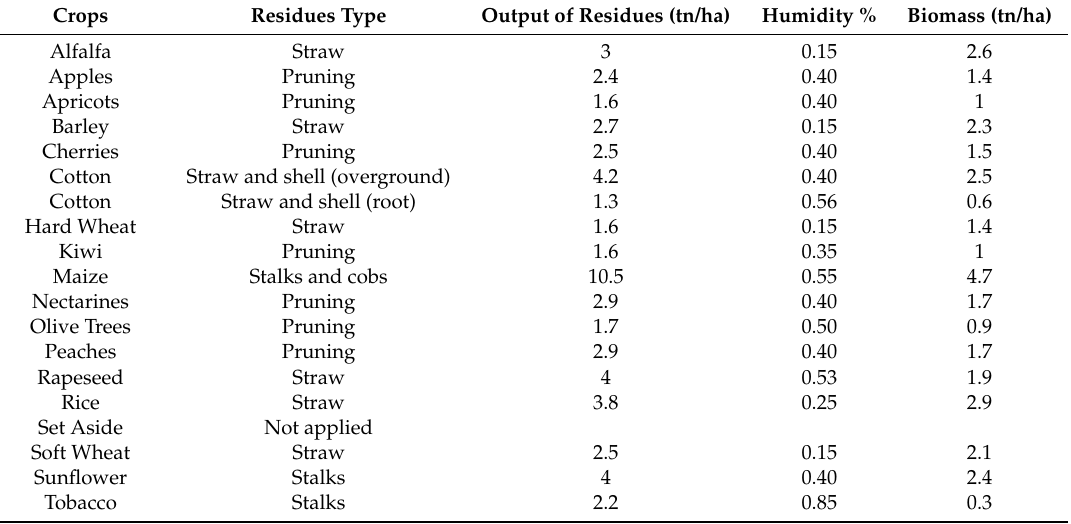
Table 2. Biomass production (tn/ha) from crops residues for the main crops of the Region of Central